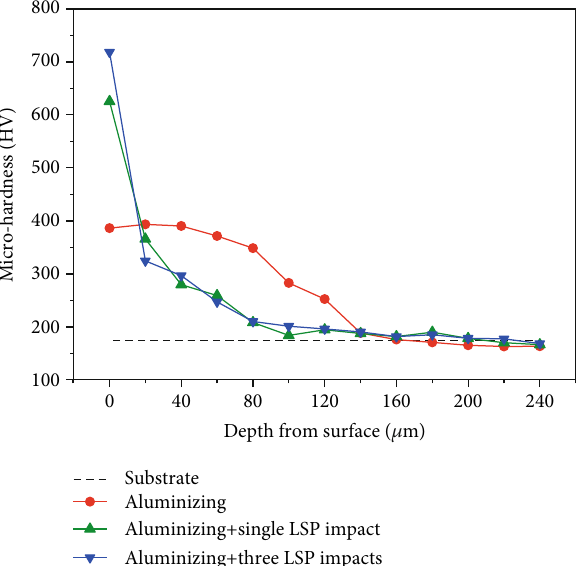
Figure 3: Microhardness variation along the depth of aluminized samples with di ff erent times of LSP impact.